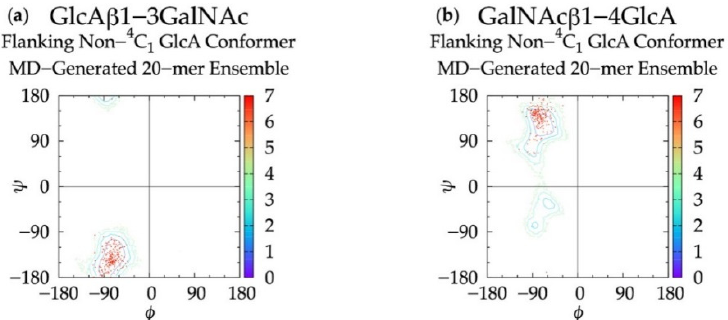
Figure 7.  G (  ,  ) plots for glycosidic linkages flanking non ‐ 4 C 1 GlcA conformers in non ‐ sulfated Figure 7. ∆ G ( φ , ψ ) plots for glycosidic linkages flanking non- 4 C 1 GlcA conformers in non-sulfated chondroitin 20 ‐ mer MD ‐ generated ensembles: ( a ) GlcA β 1 ‐ 3GalNAc and ( b ) GalNAc β 1 ‐ 4GlcA. chondroitin 20-mer MD-generated ensembles: ( a ) GlcA β 1-3GalNAc and ( b ) GalNAc β